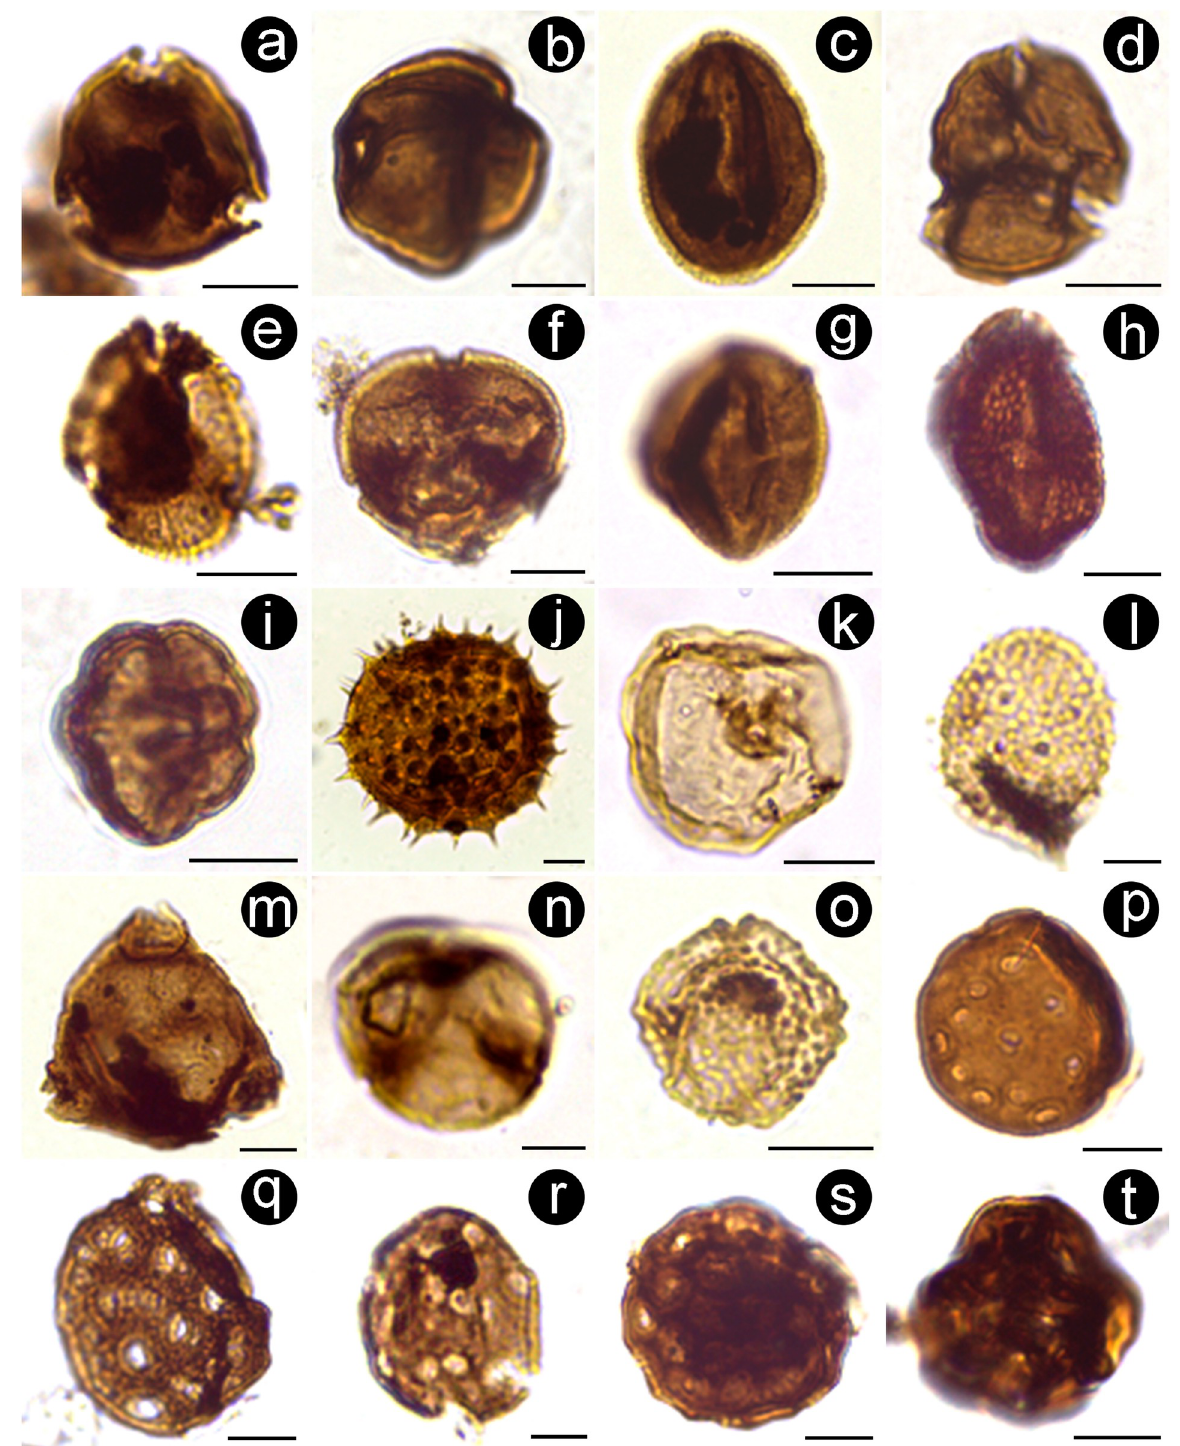
Fig 6. Microscope images of selected pollen grains from the Casa Grande Formation. (A) Beaupreadites sp. (PAL JUA (P) Cz/Plg. N˚ 001b (Eo)+10 μ m: 7.5–142). (B) Siltaria dilcheri (PAL JUA (P) Cz/Plg. N˚ 001d(Eo)+10 μ m: 17–151.2). (C) Foveotricolporites sp. (PAL JUA (P) Cz/Plg. N˚ 001b(Eo)+10 μ m: 15.5–141.5). (D) Margocolporites tenuireticulatus (PAL JUA (P) Cz/Plg. N˚ 001a(Eo)+10 μ m: 23–141). (E) Ailanthipites sp. (PAL JUA (P) Cz/Plg. N˚ 001b(Eo)+10 μ m: 19–149). (F) Bombacacidites sp. (PAL JUA (P) Cz/Plg. N˚ 001e(Eo)+10 μ m: 8–153.2). (G) Rhoipites baculatus (PAL JUA (P) Cz/Plg. N˚ 001c(Eo)+10 μ m: 24–149.9). (H) Rhoipites guianensis (PAL JUA (P) Cz/Plg. N˚ 001e(Eo)+10 μ m: 10–152). (I)